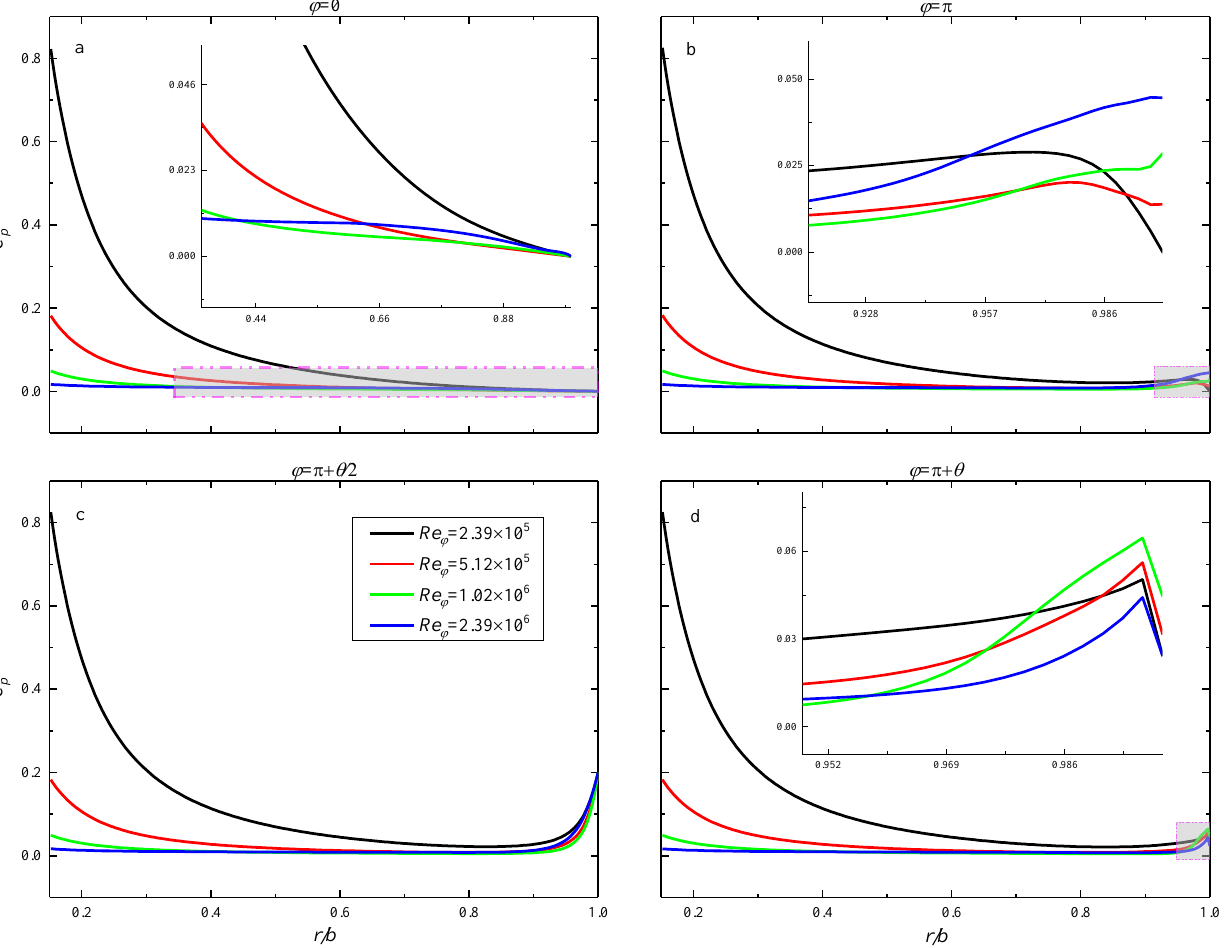
Figure 19. Pressure coefficient for C w = 10,137, E = 0.2, θ = 0.1 at plane z / s = 0.5: ( a ) φ = 0, ( b ) φ = π , ( c ) φ = π + θ /2, ( d ) φ = π + θ